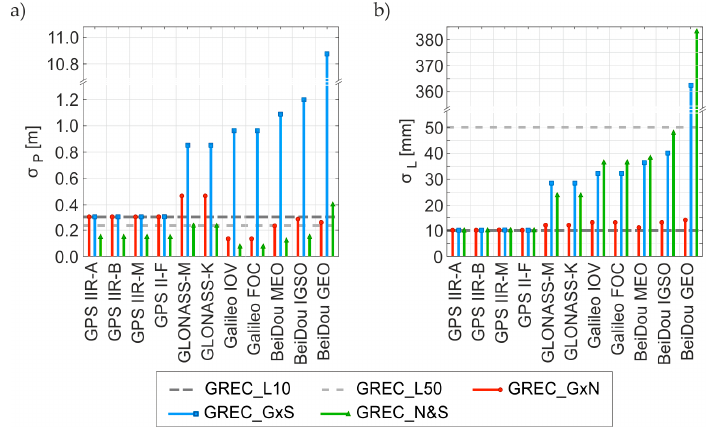
Figure 4. Comparison of weighting schemes for ( a ) pseudoranges and ( b ) carrier-phase measurements.